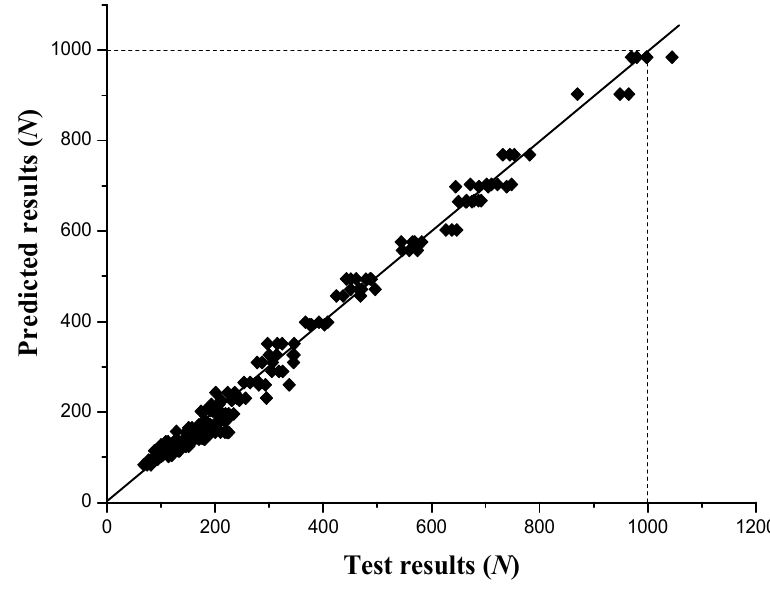
Figure 14. Predicted shear strength compared to experimental results.